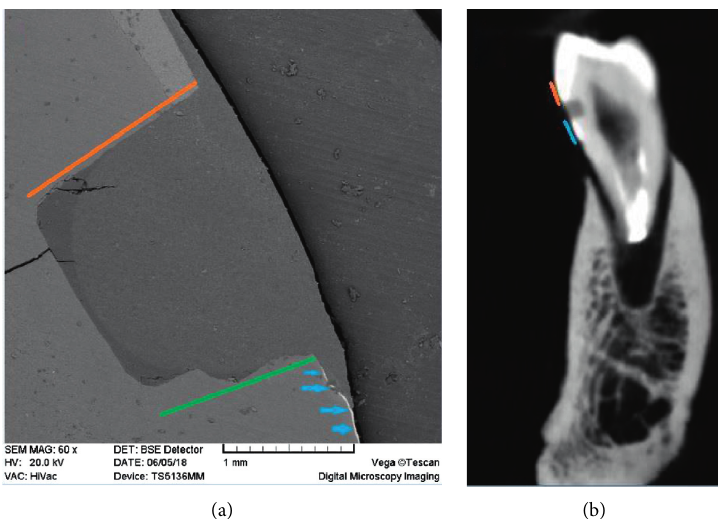
Figure 5: Silver nitrate leakage along gingival and coronal walls of a composite resin restoration. (a) Red line: coronal wall; green line: gingival wall; blue arrows: silver nitrate. (b) Red line: enamel radiopacity; blue line: silver nitrate radiopacity.